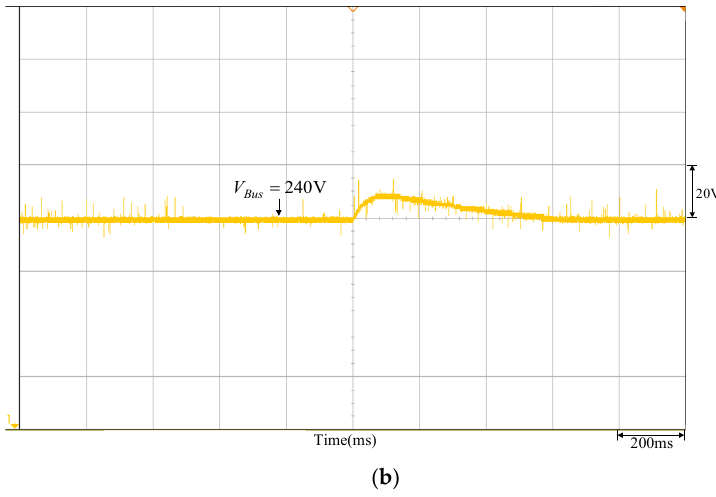
Figure 14. DC-link voltage response waveform of the quantitatively designed controller: ( a ) sunlight drops to 900 W/m 2 from 1000 W/m 2 ; ( b ) sunlight increases to 1000 W/m 2 from 900 W/m 2 .